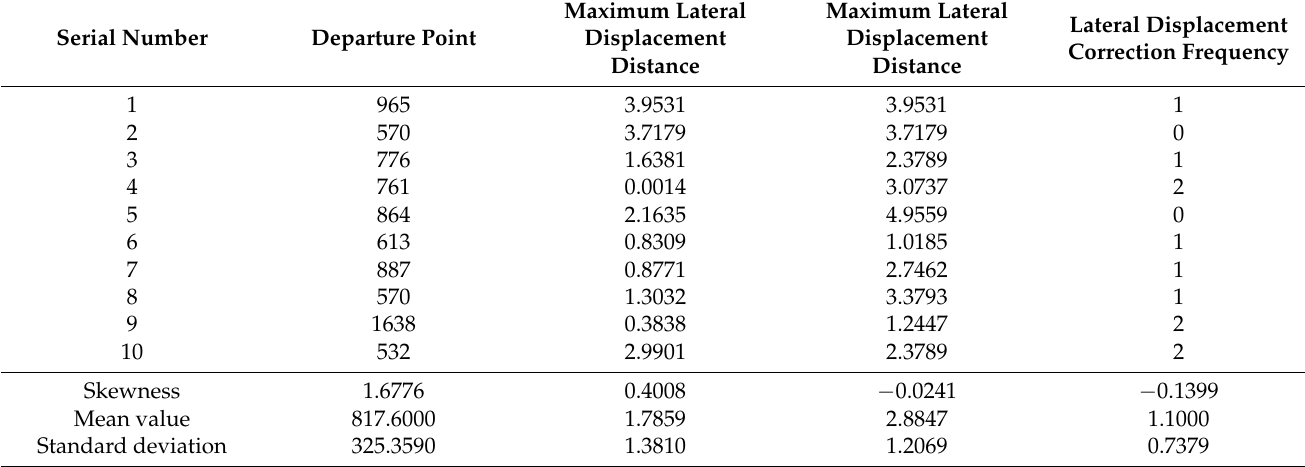
Table 12. Horizontal offset simulation data.